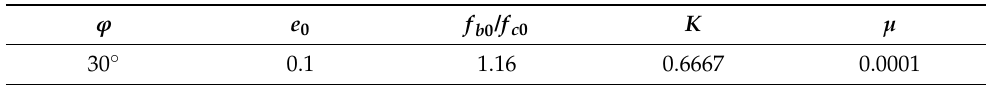
Figure 4. Illustration of CDP model: ( a ) deviatoric plane yield surface; ( b ) plane stress yield surface. Table 2. Plastic damage parameters of UHPC.